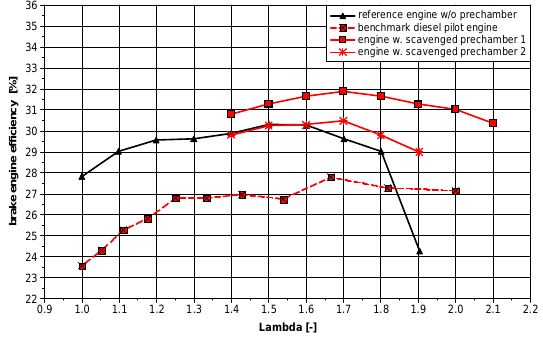
Fig. 7. Brake engine efficiencies for the operating point 1 (1400 rpm/ 50 Nm/bmep 3.2 bar)